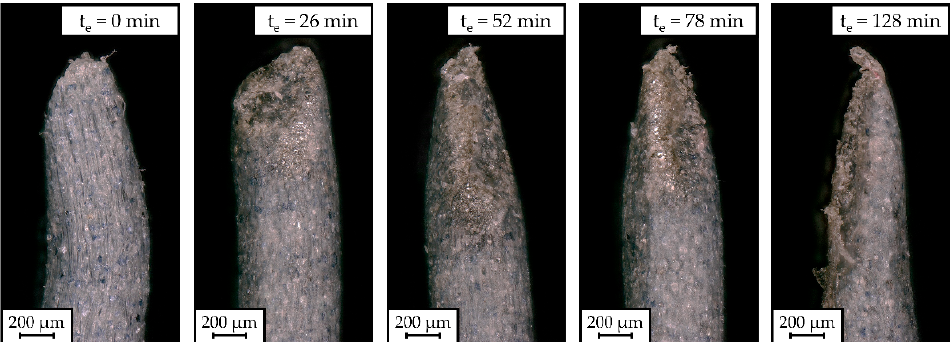
Figure 7. Microscopies of single filaments (S320x0.60) after different process